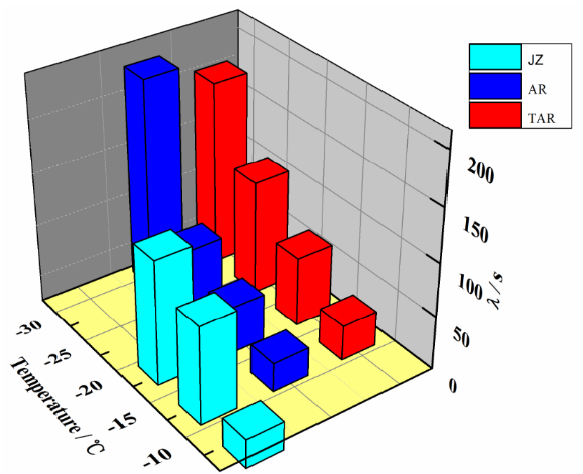
Figure 19. The variations of relaxation time (λ).